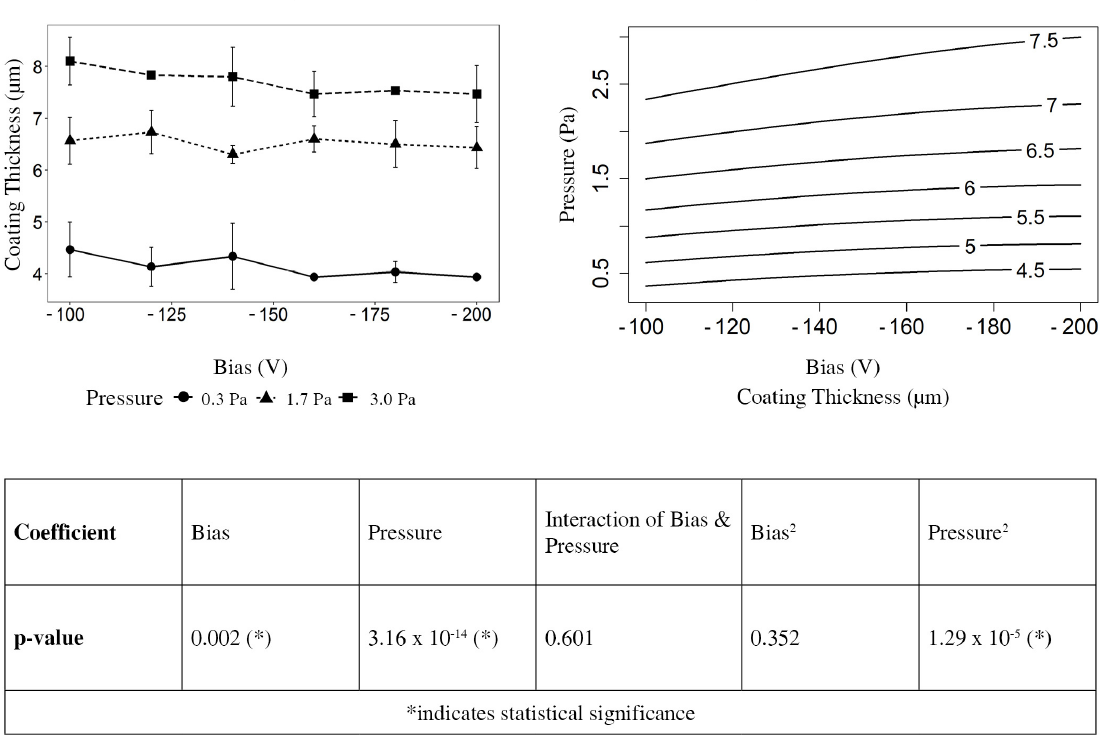
Figure 1. Scatter plot and response surface of the coating thickness.